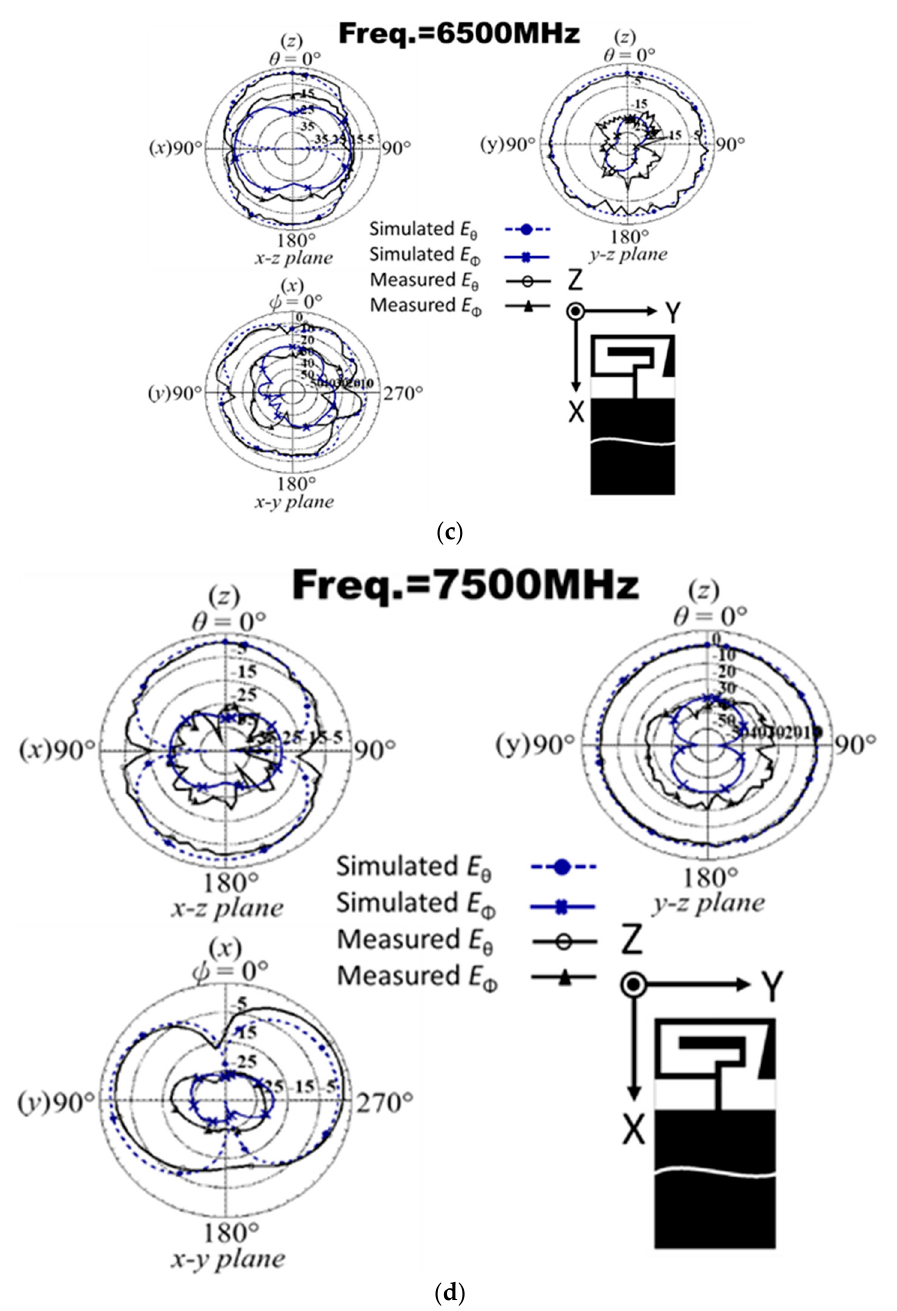
Figure 6. Simulation and measurement of radiation patterns at different operating frequencies: ( a ) 2450; ( b ) 5500; ( c ) 6500; ( d ) 7500 MHz.